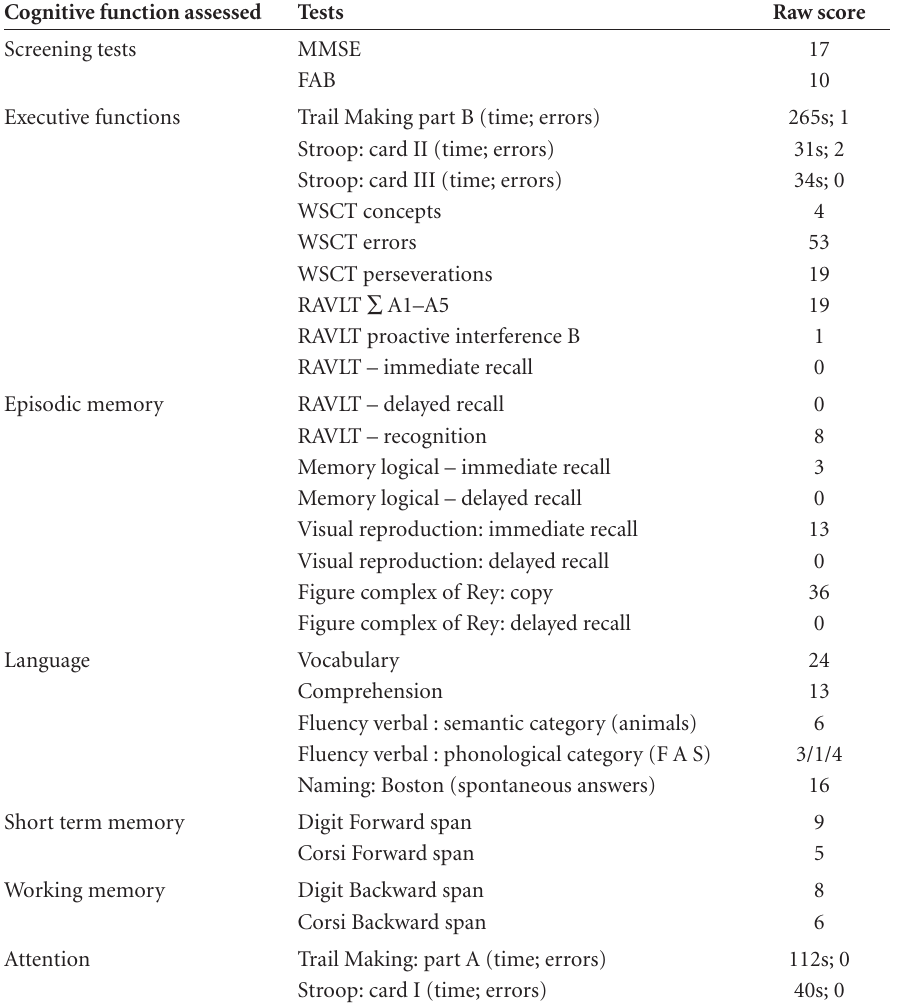
Table 1. Neuropsychological assessment results. Cognitive function